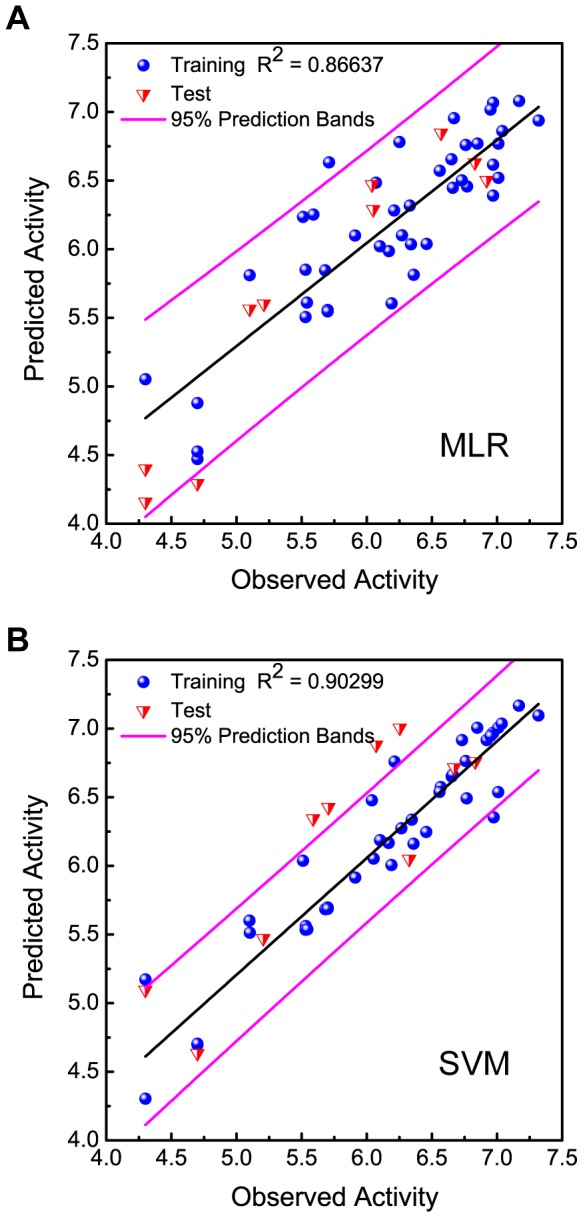
Correlation between predicted and observed bioactivities (pIC50) using the (A) MLR and (B) SVM models.